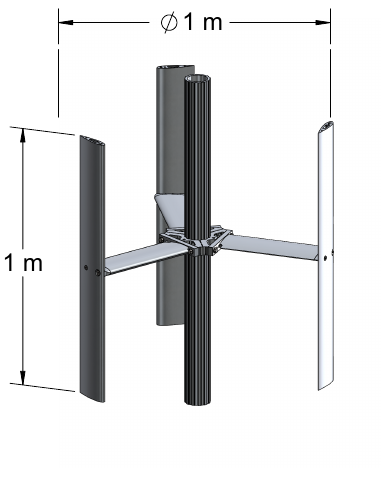
Figure 1. University of New Hampshire Reference Vertical Axis Turbine (UNH-RVAT) turbine model. Turbine blades and struts made from NACA 0020 profiles with 0.14 m chord. Note that the upper and lower mounting flanges have been excluded, as these were included in the tare drag